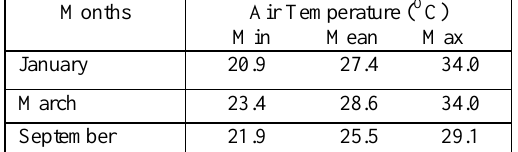
Table 4. Summary of Air Temperature Analysis for the different Months